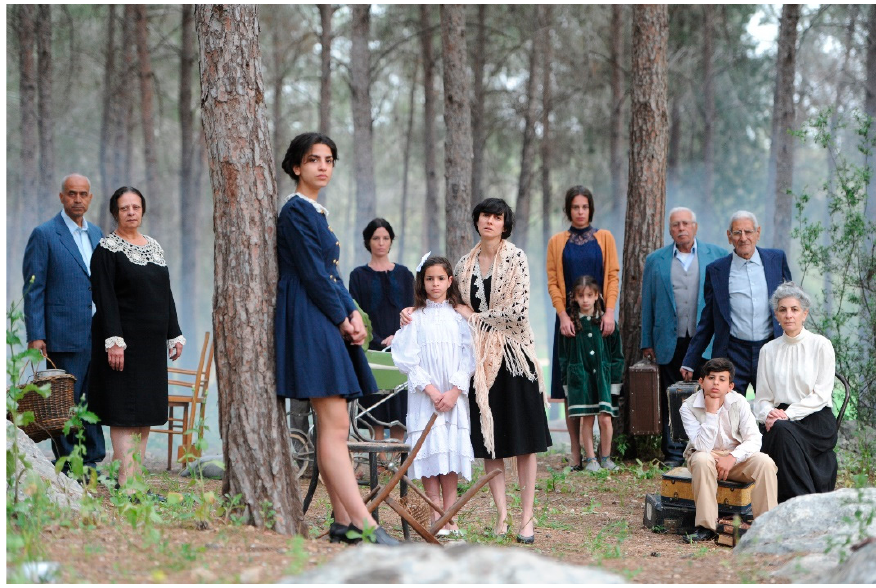
Figure 2. Raida Adon, Strangeness , 2018, Video, 33:30 mins. © Tami Weiss.